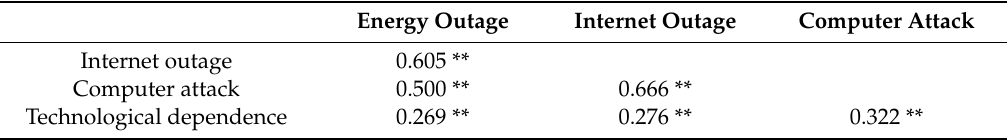
Table 3. Pearson correlation coe ffi cients of perceived dangers.